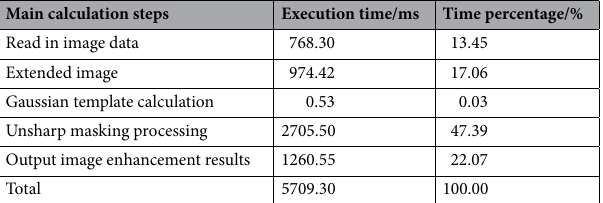
Table 1. Running time and proportion of each step of the image UM algorithm.